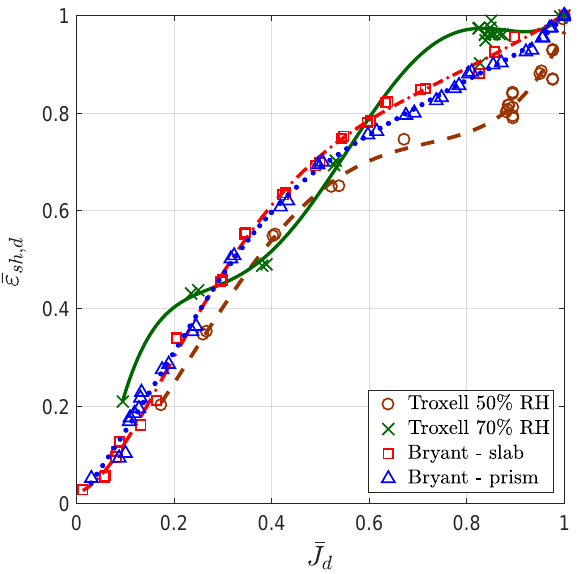
Figure 4. Comparison of normalized drying shrink- age and normalized drying creep evaluated from the experiments of Troxell and Bryant. Only the points represent the experimental data.